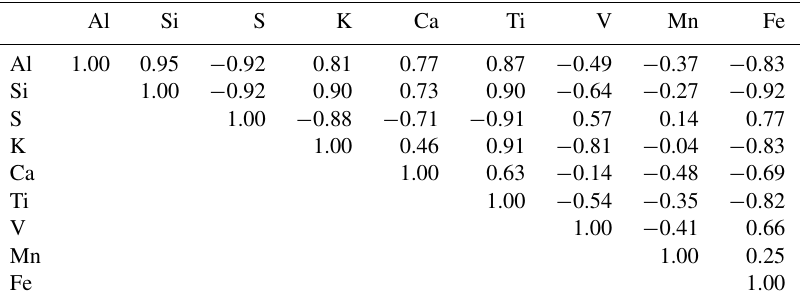
Table 1. Correlation matrix for the XRF profiles from Lake Kälksjön composite profile KKJ19.